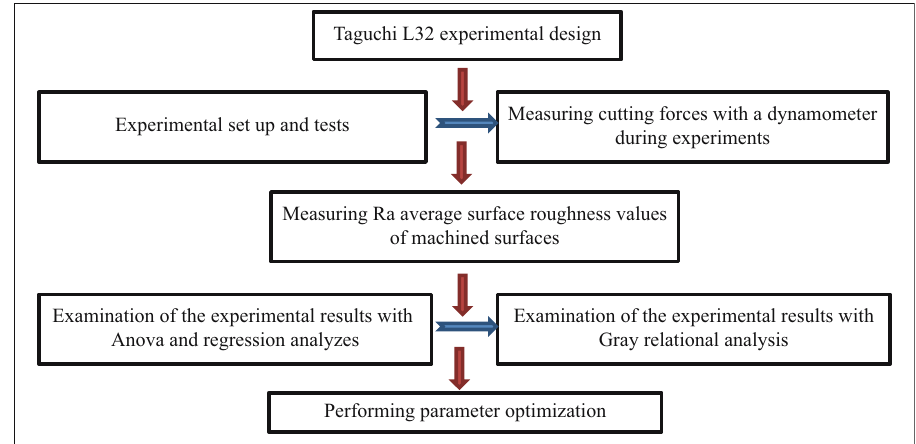
Figure 2: Work fl ow of the study.